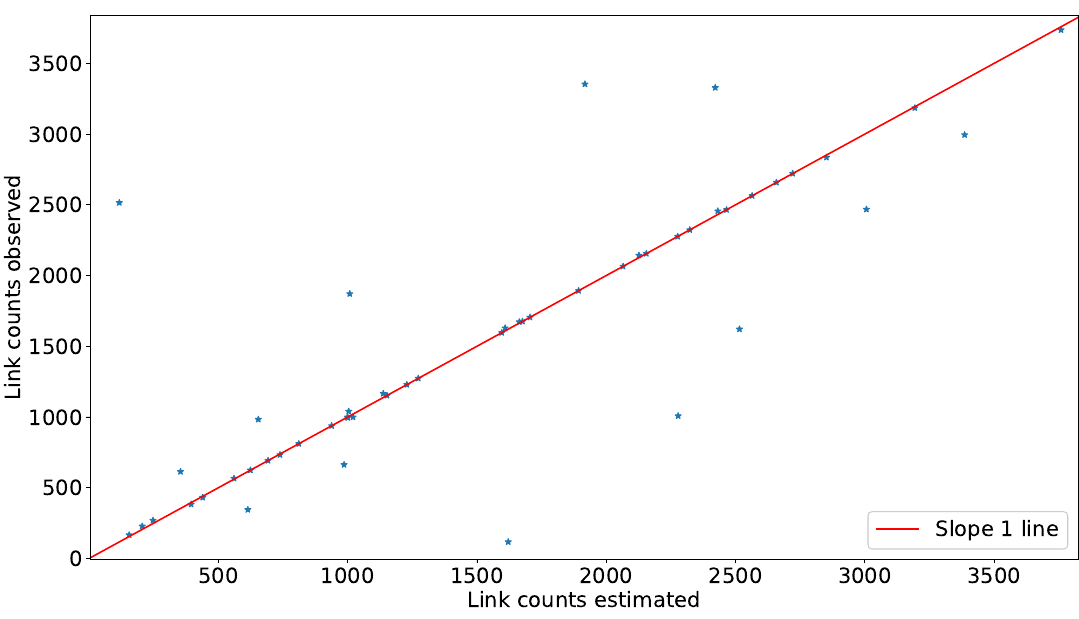
Figure 11. Scatter plot to compare estimated OD flow with the observed OD flow.